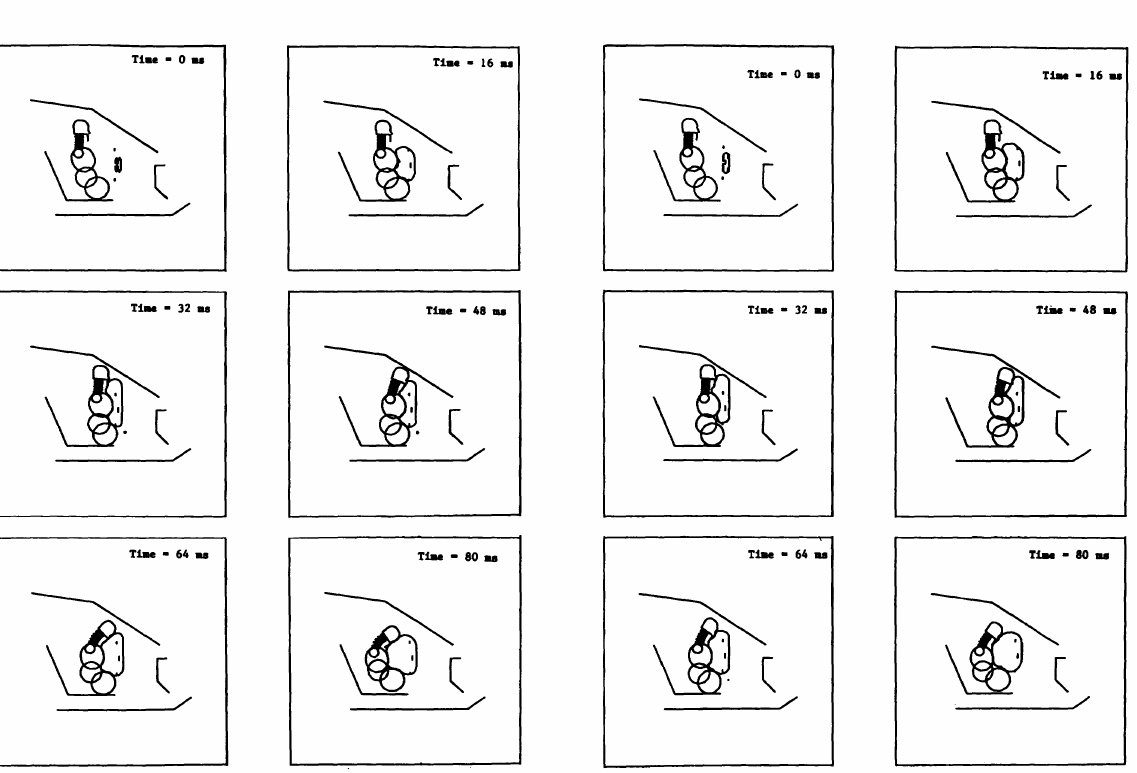
FIGURE 8 The midsagittal view of an occupant in a car with an accordion fold airbag at 0° (case I).